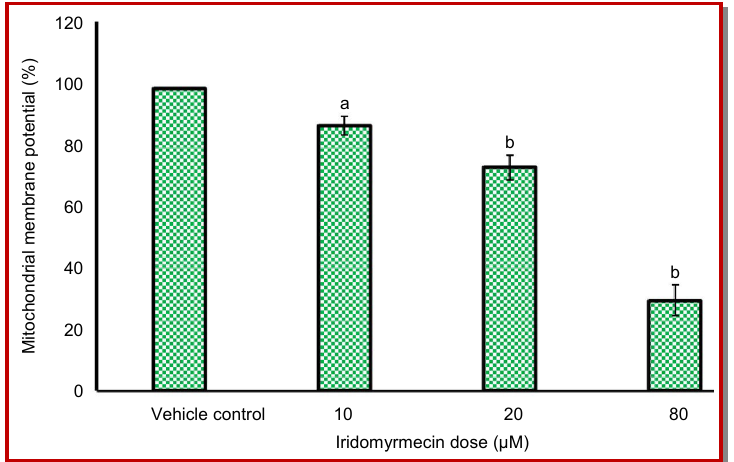
Figure 4: Iridomyrmecin led to loss of mitochondrial membrane potential loss in HeLa human cervical cancer cells. The cells were treated with 0, 10, 20 and 80 µM dose of iridomyrmecin for 48 hours and then stained with Rh-123 fluorescent dye and finally analyzed by flow cytometry. Data are shown as the mean ± SD of three independent experiments. a p<0.05, b p<0.01 vs 0 µM (c